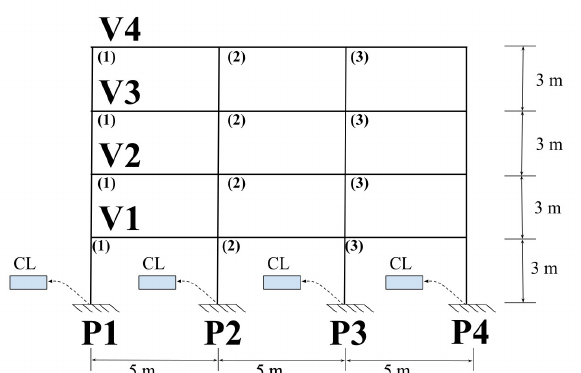
Figure 2. Plane frame in reinforced concrete analyzed and nomenclature of the columns, beams, and column layout